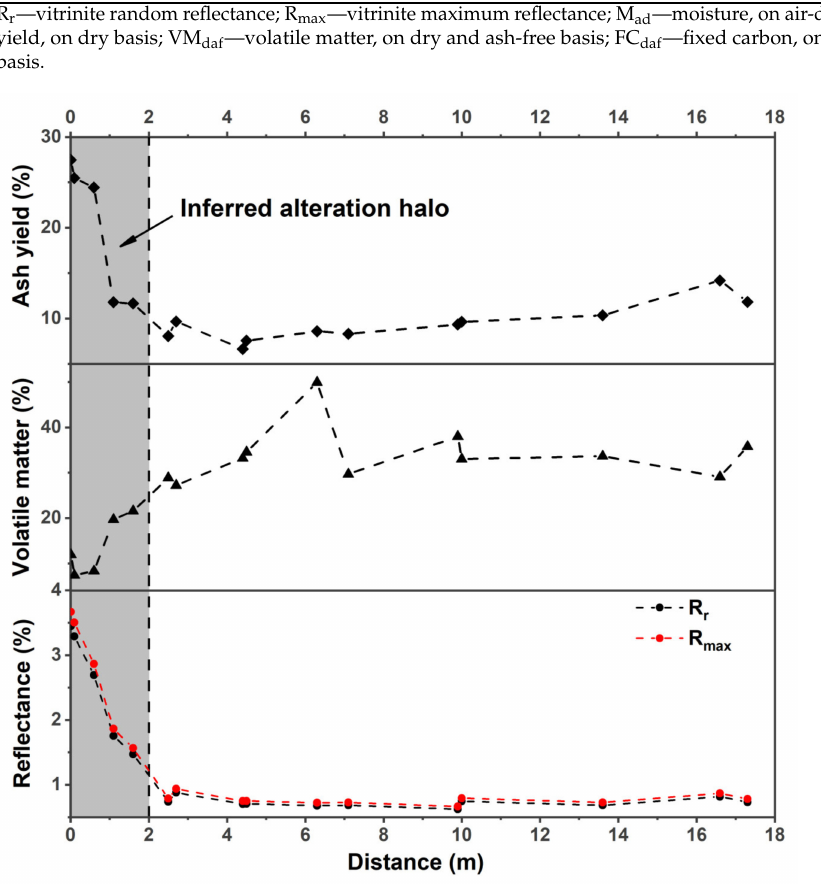
Figure 4. Ash and volatile matter yields; vitrinite reflectance versus distance from the dike in the Tashan Coal